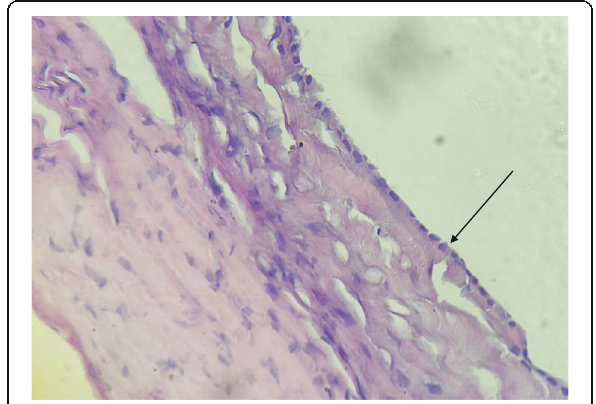
Fig. 7 Showing H and E stained LP (magnification 100x) and HP (magnification 400x) photomicrographs of a cyst wall lined by flattened epithelium (red arrow), congested blood vessels and focal dense infiltration by lymphocytes consistent with a diagnosis of Infected Peritoneal Inclusion Cyst